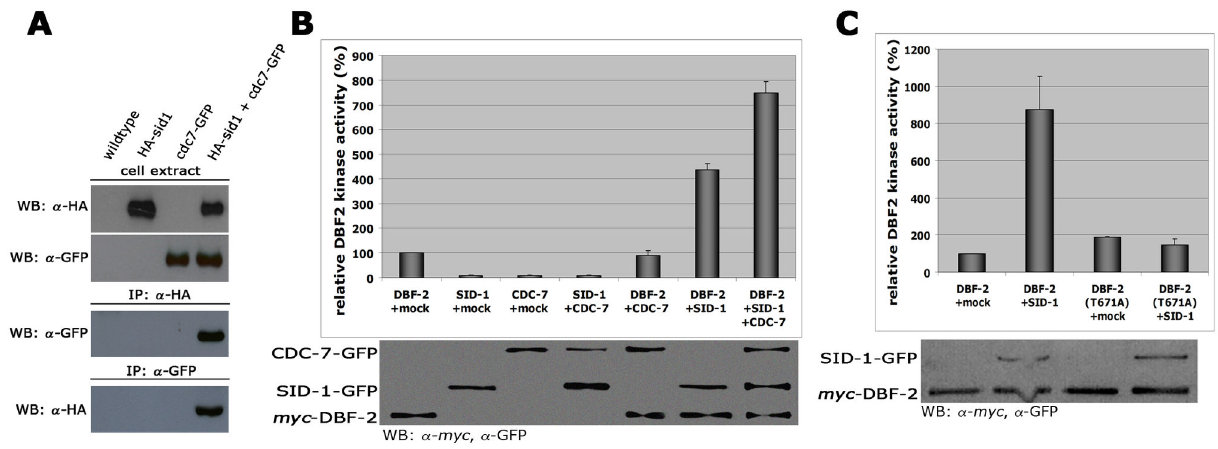
Figure 3. CDC-7-dependent activation of DBF-2 occurs through SID-1 (A). Reciprocal co-immunoprecipitation experiments of CDC-7-GFP and HA-SID-1 from cell extracts co-expressing both functionally tagged proteins indicate interaction of the two kinases. ( B ) In vitro DBF-2 activity assays revealed that addition of separately purified SID-1 stimulate DBF-2. SID-1-dependent stimulation of DBF-2 was further increased by addition of CDC-7 to the reaction. As control, CDC-7 alone did not stimulate DBF-2 (n = 5). To confirm equal precipitation of protein used for the kinase reactions, the kinase-sepharose pellet after the kinase reaction was boiled in Laemmli buffer and the supernatant used to determine equal protein abundance by SDS-PAGE and Western blot. ( C ) SID-1 was able to stimulate DBF-2, but not DBF-2(T671A). Western blot analysis of the precipitated proteins was used to determine comparable kinase levels (n =